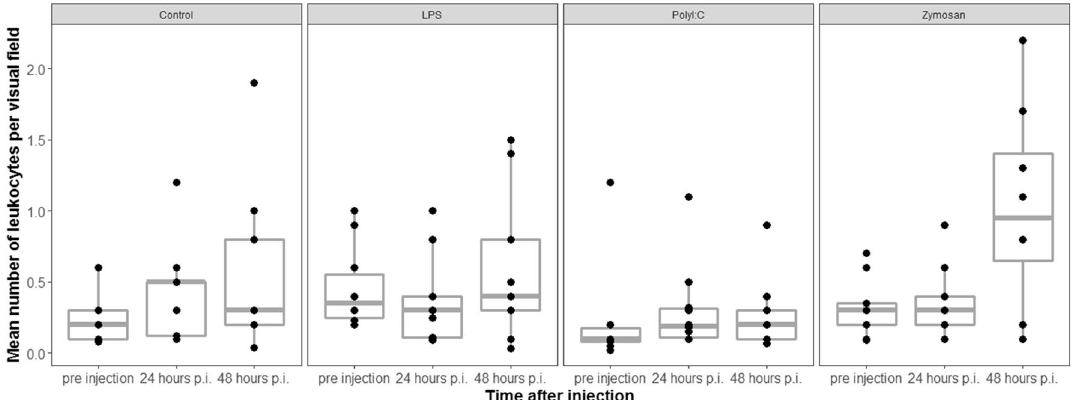
Figure 5. The number of total leukocytes was not affected by antigen type. p.i. = post injection. The figures show medians (bold line), 25–75% percentiles (box), maxima and minima (whiskers) and data points (dots).